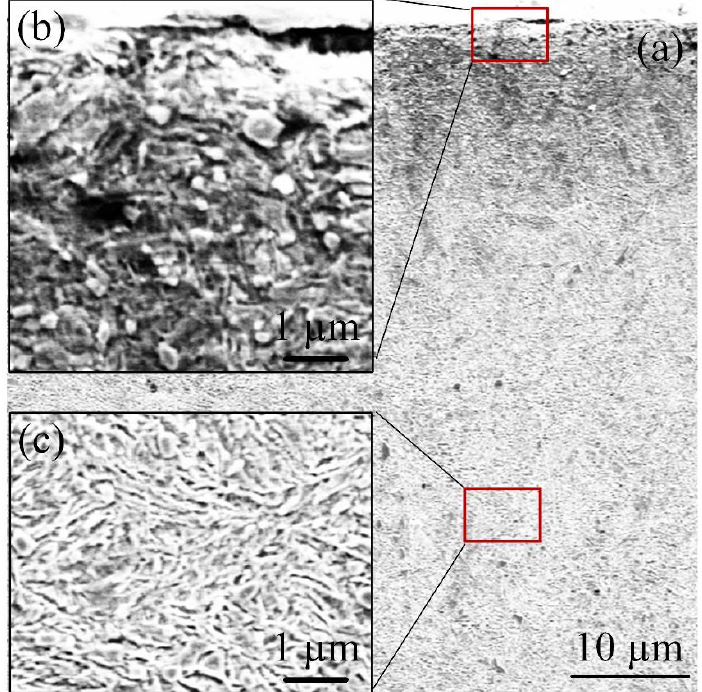
Figure 7. Cross-sectional microstructures of sample S2 after AWJP treatment.